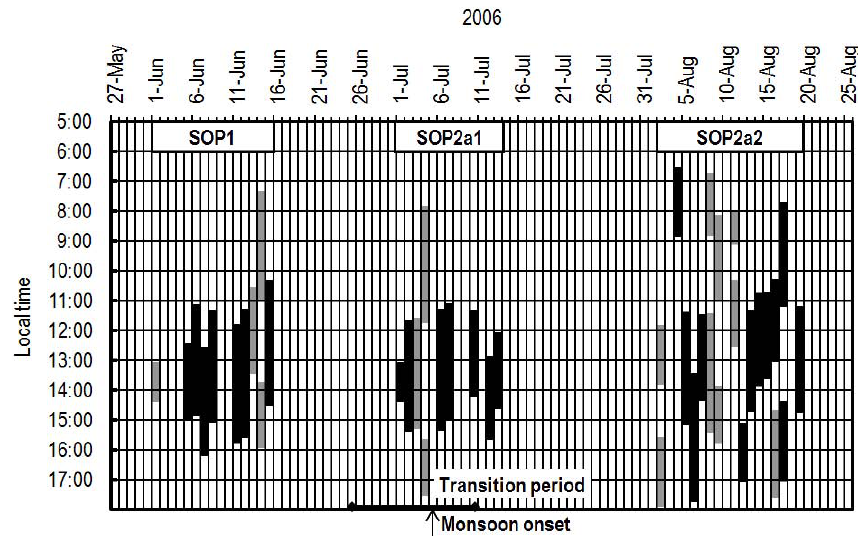
Fig. 1. Time scale of the AMMA Special Observation Periods (SOP) and flight hours of the intensive aircraft measurements. Shaded areas correspond to the duration from take-off to landing of the ATR-42 aircraft. Flights indicated in black are the vertical exploration flights conducted in the vicinity of Niamey (13 ◦ 30 0 N, 02 ◦ 05 0 E), on which results in the current study are based on. Date of the 2006 monsoon onset and the transitional period are depicted as defined by Janicot et al. (2008).